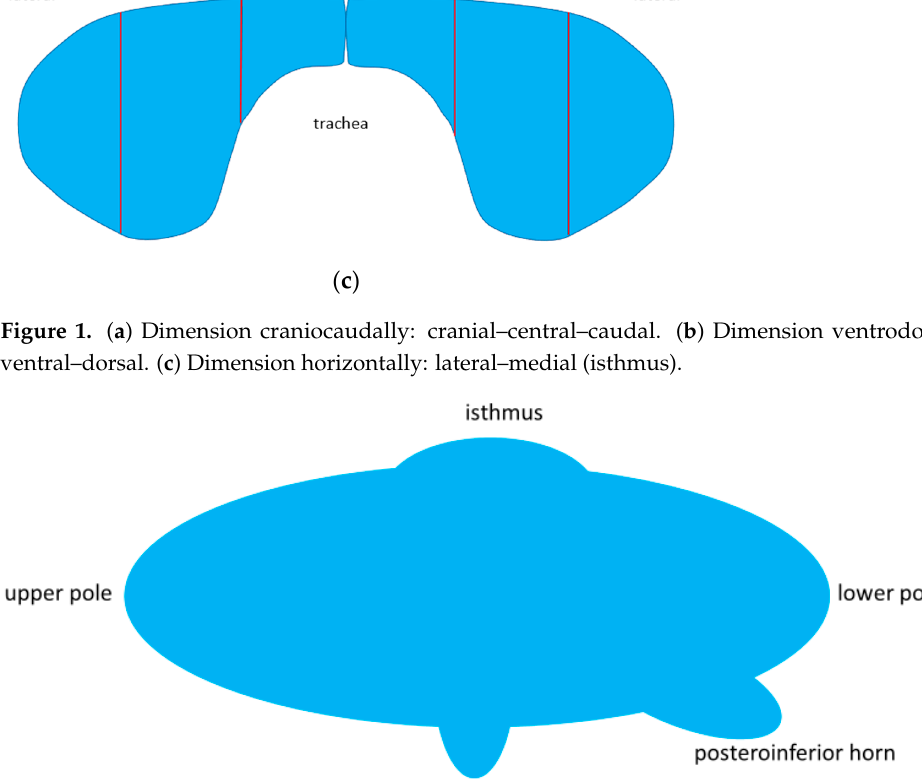
Figure 1. ( a ) Dimension craniocaudally: cranial–central–caudal. ( b ) Dimension ventrodorsally: ventral–dorsal. ( c ) Dimension horizontally: lateral–medial (isthmus).